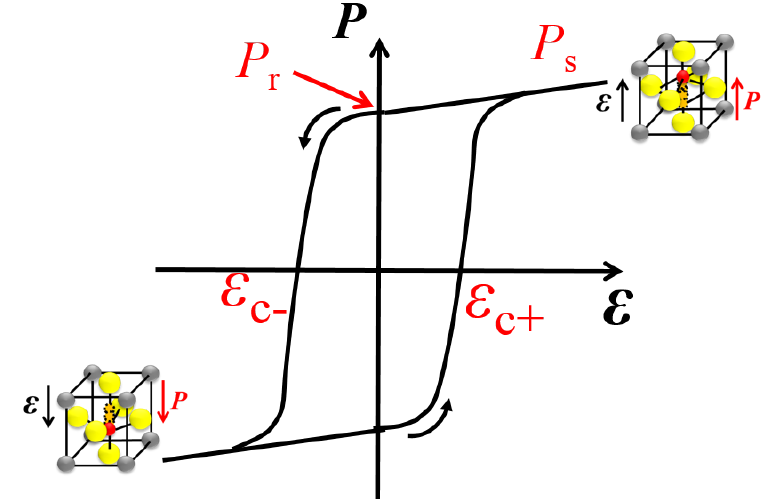
Figure 2. Schematic P - E curve illustrating the hysteretic effect caused by internal dipoles. The remnant polarization P r represents the polarization at zero field. The saturation polarization P s is the maximum polarization at which a spontaneously formed dipole moment has been formed. E C − and E C + are the coercive fields at which the hysteresis loop intersects the negative respectively positive field